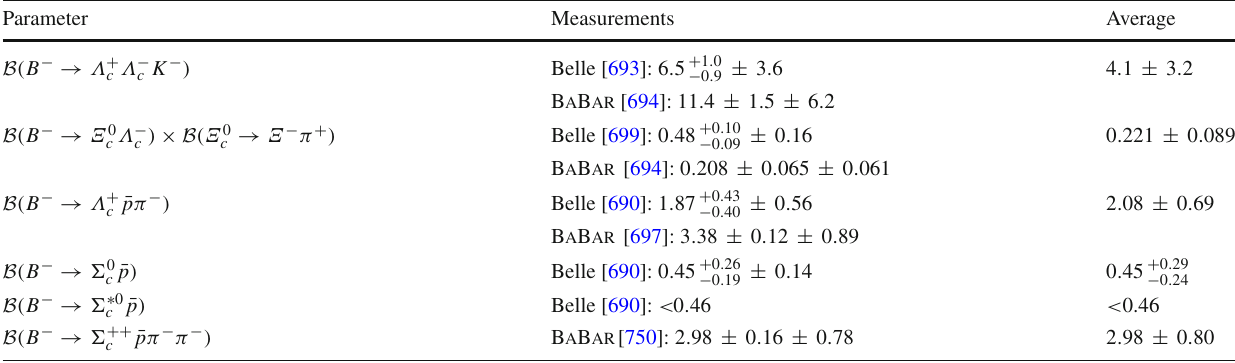
Table 170 Absolute (product) decay rates [ 10 − 4 ]